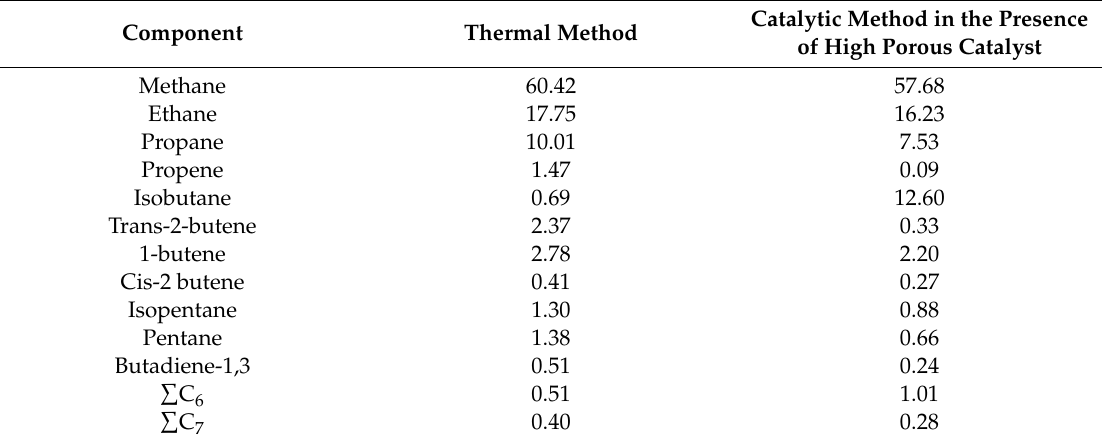
Table 4. Hydrocarbon components content (% vol.) in gas phase of oil refining processes.